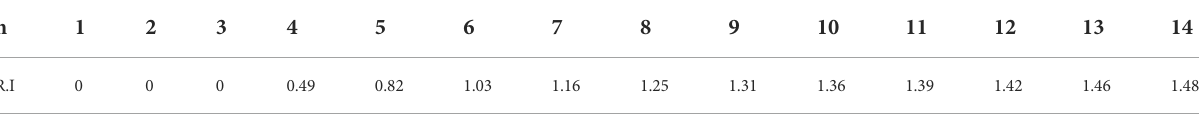
TABLE 3 Values of Random index (Noble and Sanchez,